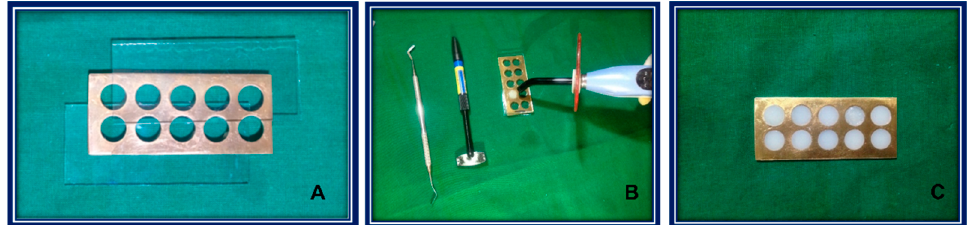
Figure 2. ( A ) Custom-made brass mold with glass plate and cellophane sheet for specimen fabrica- tion. ( B ) Preparation of specimen. ( C ) Specimens in brass mold.